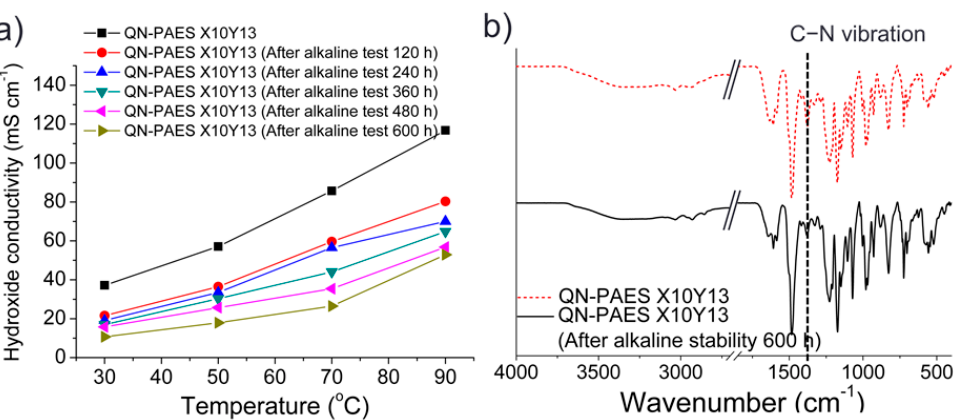
Figure 11. Alkaline stability of ( a ) QN-PAES X10Y13 membrane as a function of temperature and time, and ( b ) FT-IR spectra of QN-PAES X10Y13 membrane before and after alkaline stability test in a 2 M NaOH solution at 70 °C.